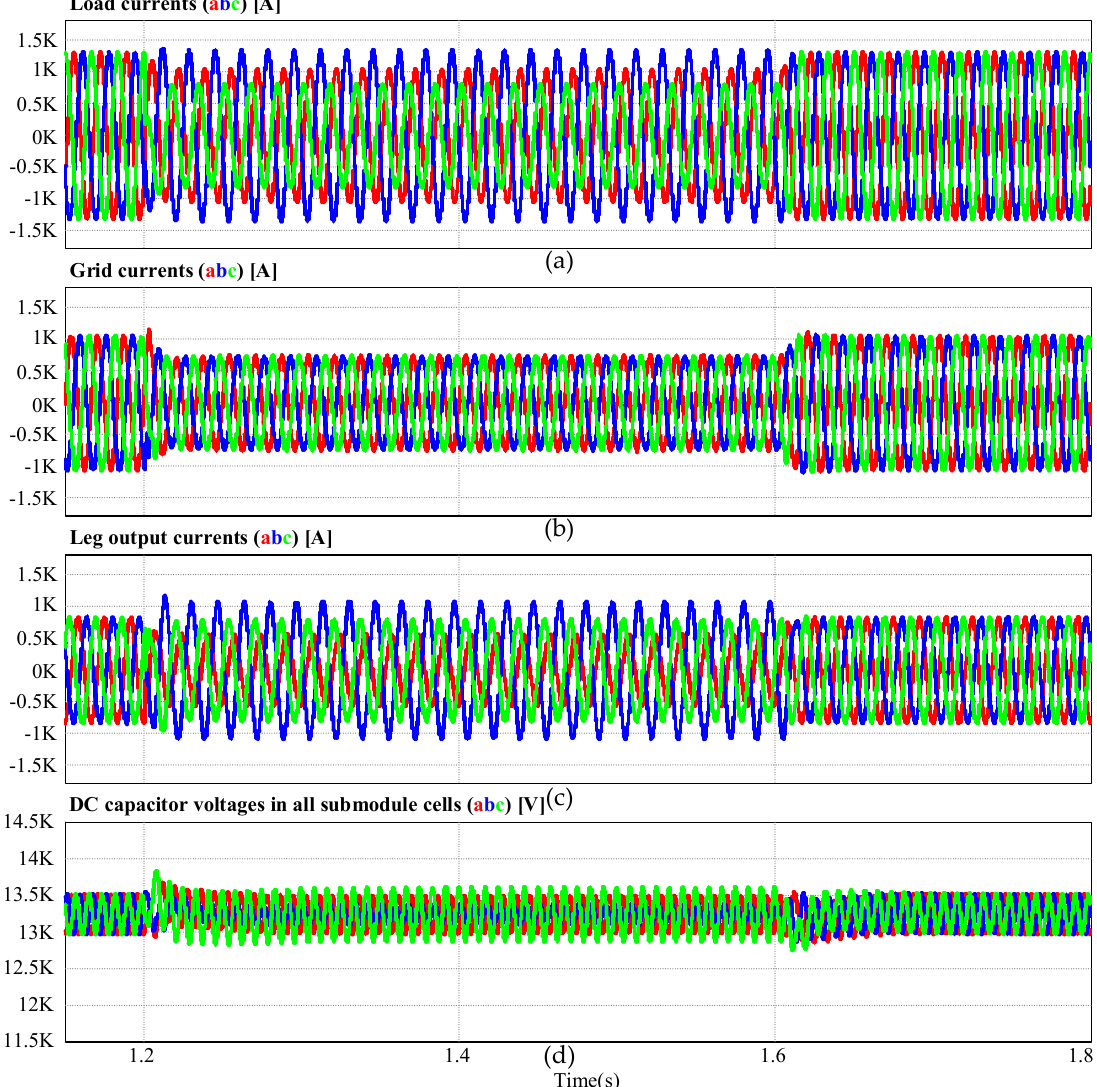
Figure 5. Simulation results under unbalanced load conditions when the proposed feedforward is applied: ( a ) three-phase load currents; ( b ) three-phase grid currents; ( c ) three-phase leg output currents; ( d ) DC capacitor voltages in all submodule cells.